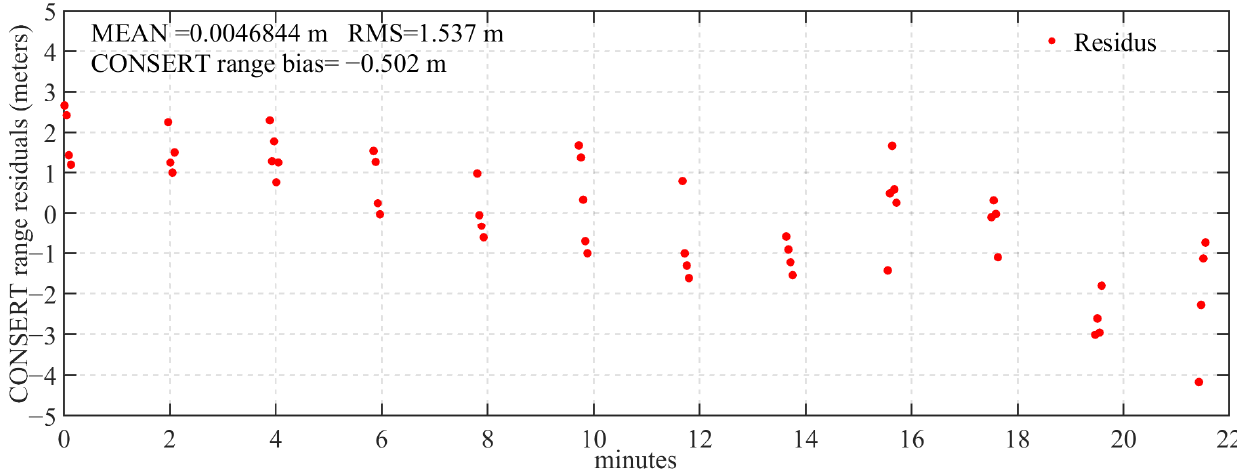
Figure 6. Post-fit residuals for CONSERT range measurements corresponding to the values of Table 7. Note the typical “burst repartition” of the 51 measurements, that is the result of CONSERT stroboscopic mode (see Appendix A).